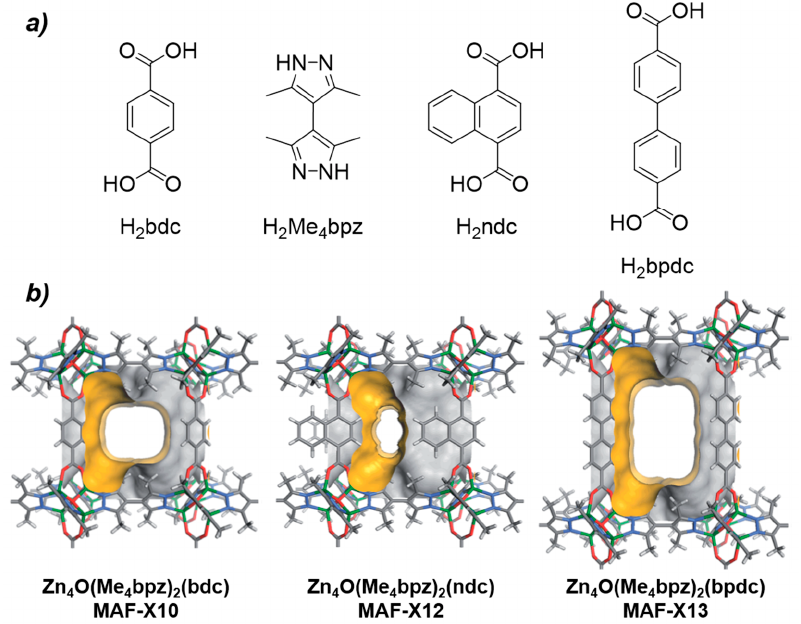
Figure 5. ( a ) Linkers used to make hydrophobic MOF-5 analogues. ( b ) Crystal structures of MAF-X10, MAF-X12 and MAF-X13 highlighting the pore surface. Adapted with permission from ref. [66].